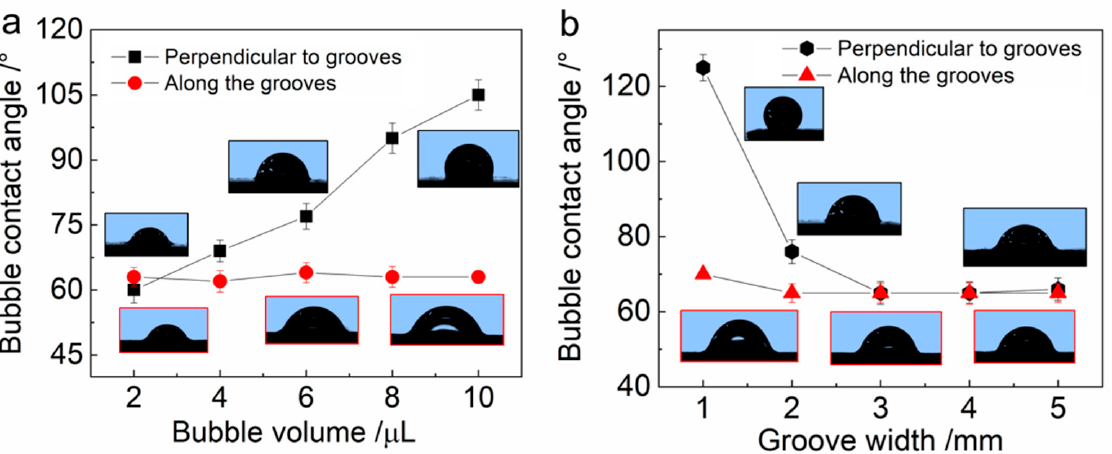
Figure 6. The influence of bubble volume ( a ) and groove width ( b ) on the bubble contact angle along the grooves and perpendicular to the grooves. It can be seen that the bubble volume and groove width have a significant effect on the bubble contact angle perpendicular to the grooves, which is mainly induced by the restriction of the slippery area during the bubble’s anisotropic spreading.